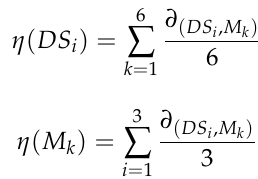
Figure 16. The model-wise average performance of three datasets.